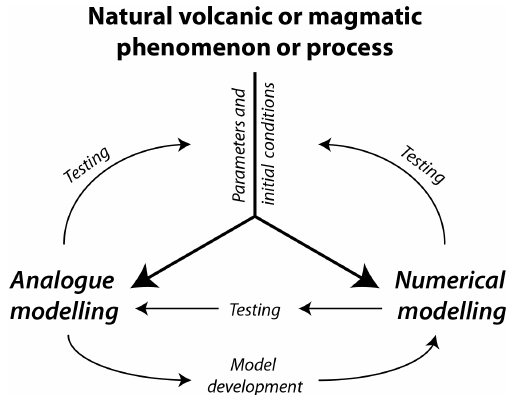
Figure 4. A flow diagram to represent the optimal approach to use analogue and numerical modelling in volcanology. Observations and measurements from natural volcanic and magmatic phenom- ena provide the parameters and initial conditions for analogue and numerical models; these models are then tested against nature, with analogue models also aiding the development of numerical